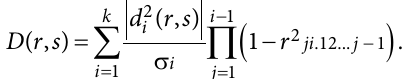
Table 3. Ranking countries by I-distance method for the selected Southeast European countries, 2007–2012